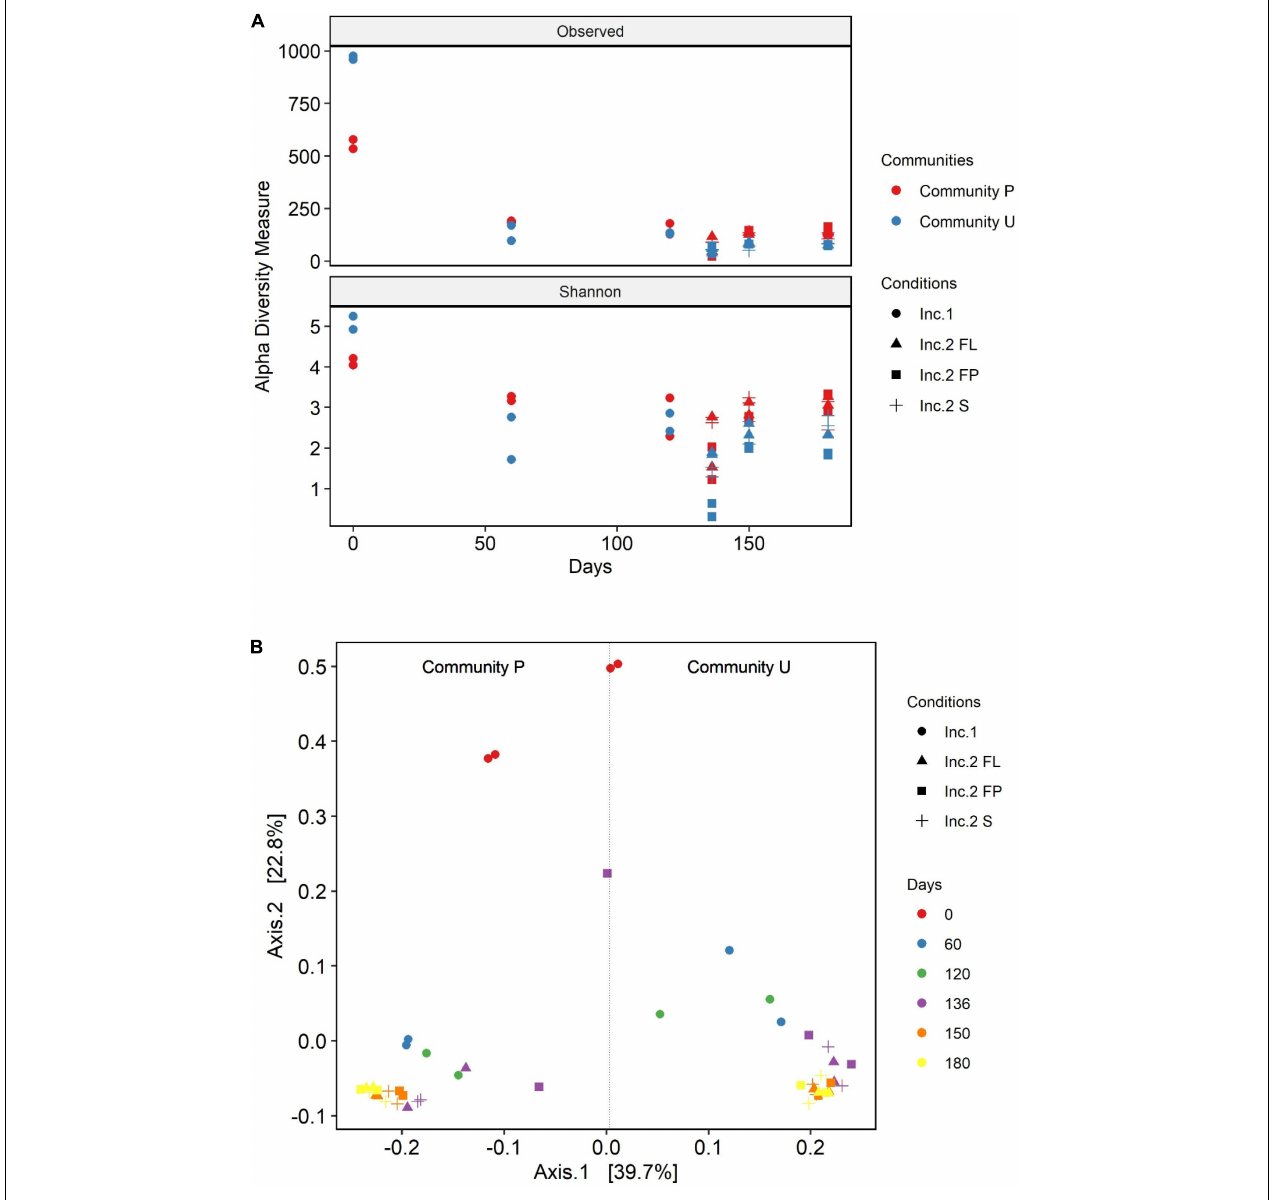
FIGURE 3 | Alpha (A) and beta (B) diversity analysis of community U and community P. The principal coordinate analysis (B) is based on the Jensen–Shannon divergence (JSD) distance. The data are from the sampling points during incubation 1 (Inc.1) day 0 to day 120 and incubation 2 (Inc. 2) for 60 days, which started